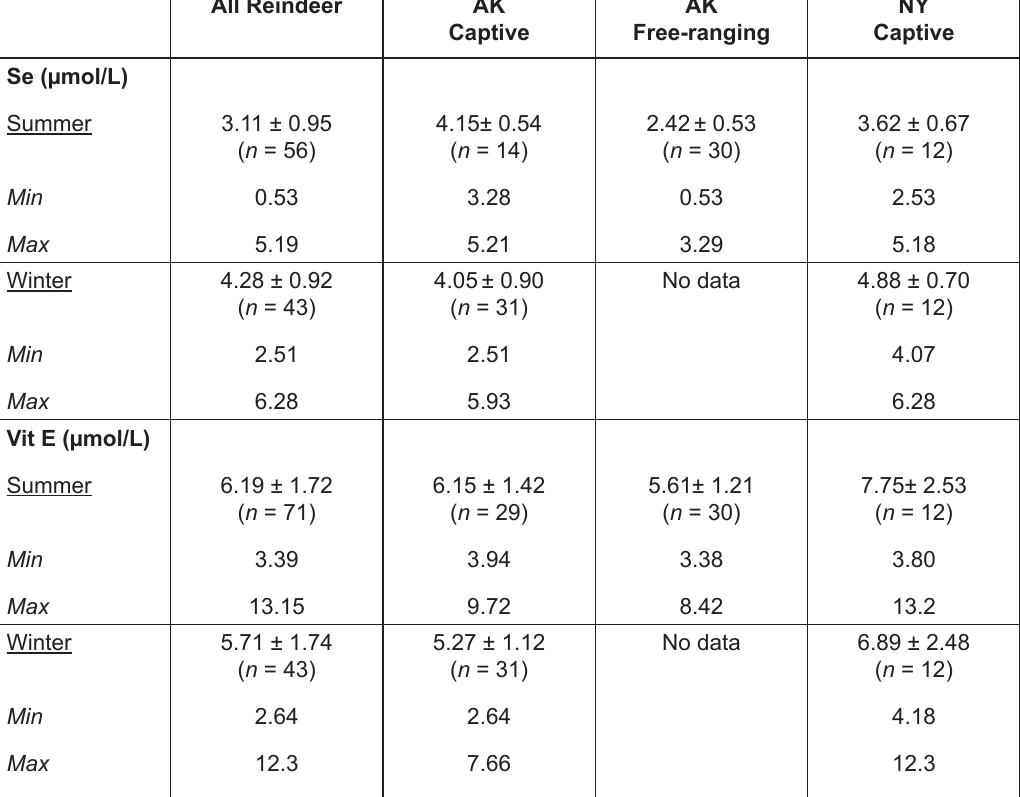
Table 2. Blood Se and vitamin E concentrations (mean values ± standard deviation, SD), number of analyzed samples ( n ), and minimum and maximum values. Samples collected in summer and winter from reindeer from captive herds in Alaska (AK) and New York (NY) and a free-ranging herd in Alaska. All Reindeer AK Captive